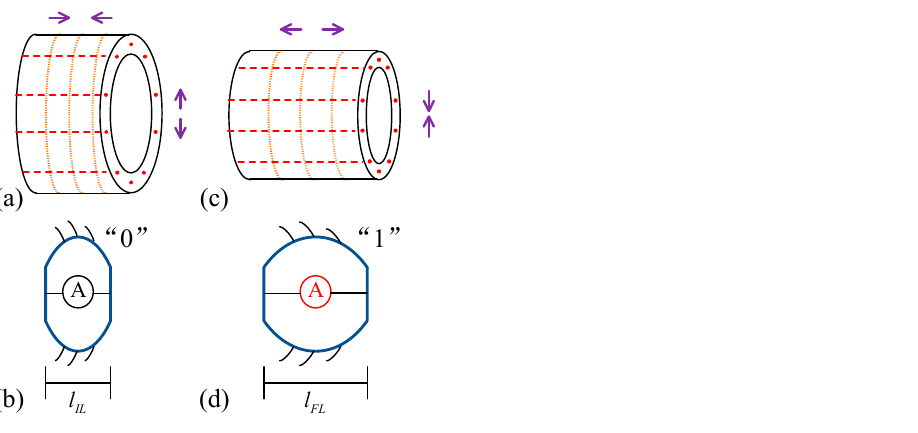
Figure 2. The kinematic state definition of the body segment of the earthworm and the earthworm- like robot. A schematic diagram of the earthworm muscles contracting the segment ( a ). The initial state of the bionic segment represents “0” in ( b ). A schematic diagram of the earthworm muscle elongating segment is shown in ( c ). The final state “1” of the bionic segment with actuation, is shown in ( d ).